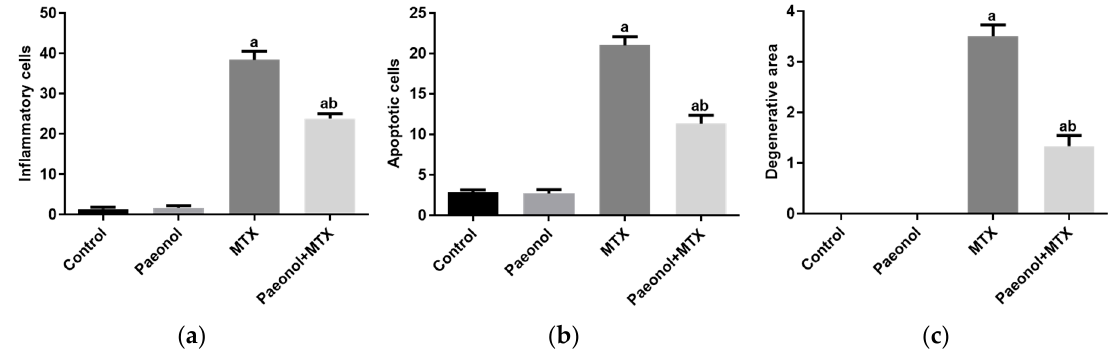
Figure 4. The effect of paeonol on the severity of histopathological lesions, ( a ) inflammatory cells, ( b ) apoptotic cells, and ( c ) degenerative area, in methotrexate (MTX)-induced hepatotoxicity in rats. Data are represented as mean ± SEM ( n = 6). Letters a,b Denote significant differences from the normal control and the MTX groups, respectively, at p < 0.05.